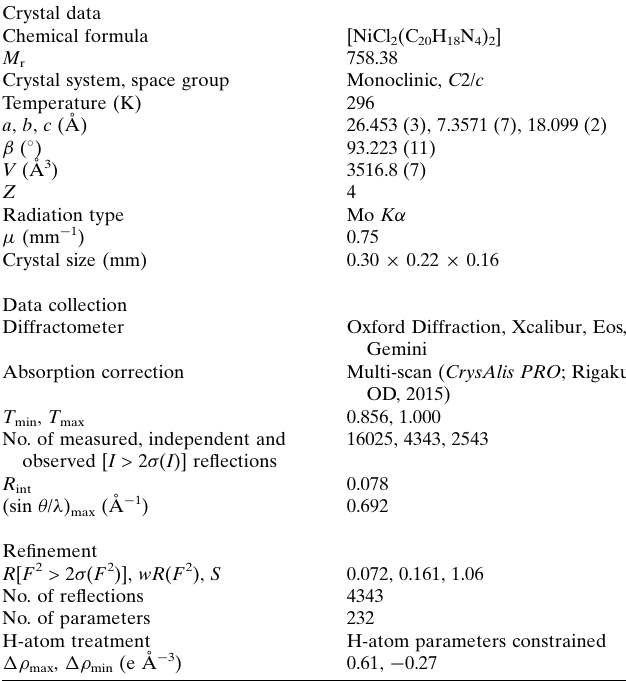
Table 2 Experimental details. Crystal data Chemical